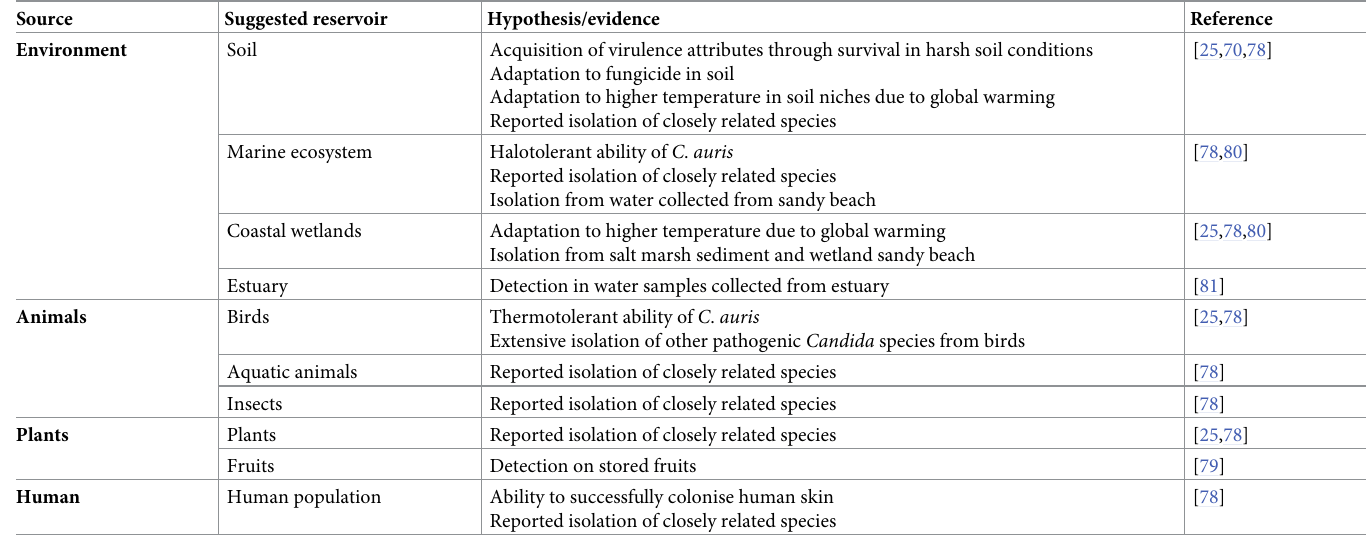
Table 2. Potential reservoirs of Candida auris